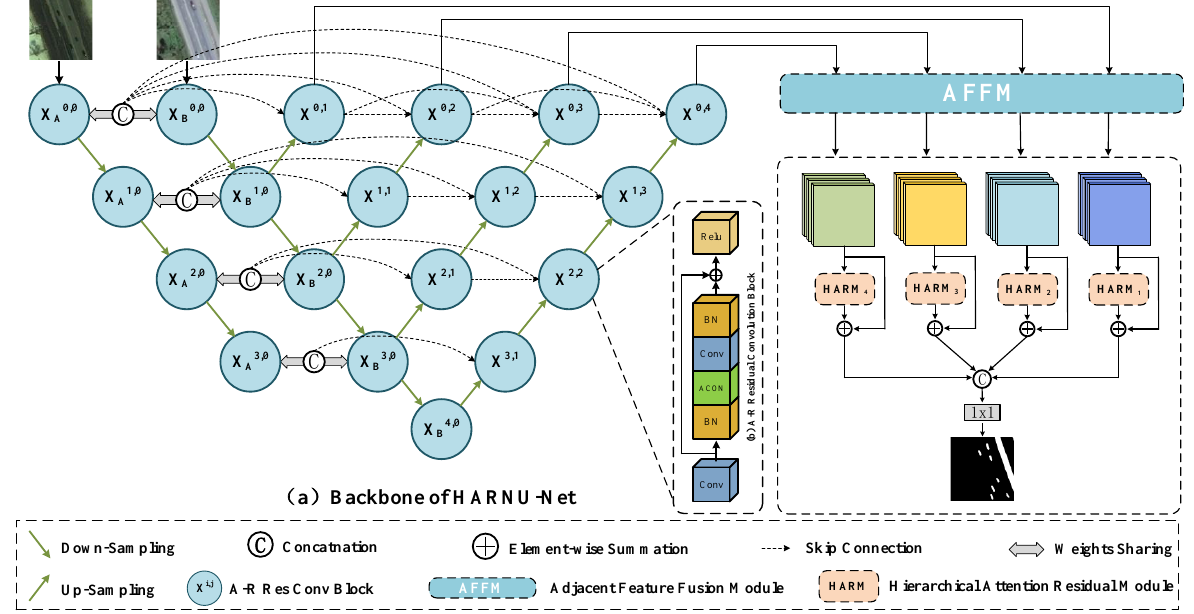
Figure 1. Architecture of the proposed HARNU-Net. ( a ) is the backbone of HARNU-Net, used for feature extraction. ( b ) is an improved convolutional block, proposed to enhance the backbone network performance. AFFM is used for feature fusion, HARM is used for feature filtering and enhancement. Detailed structure of AFFM and HARM are shown in Figures 2 and 3.